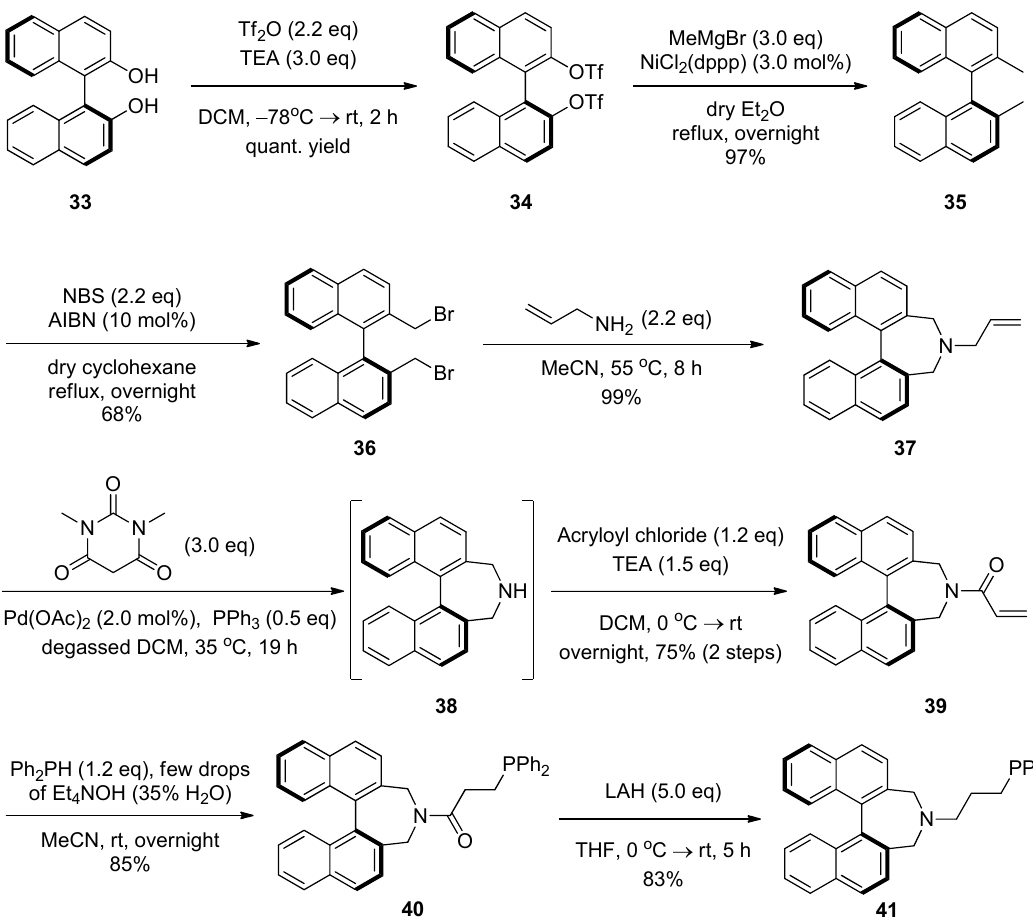
Scheme 6. Synthesis of a binol-derived aminophosphine.